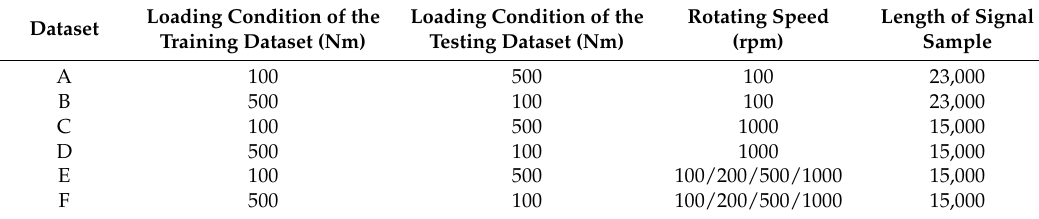
Table 5. Dataset